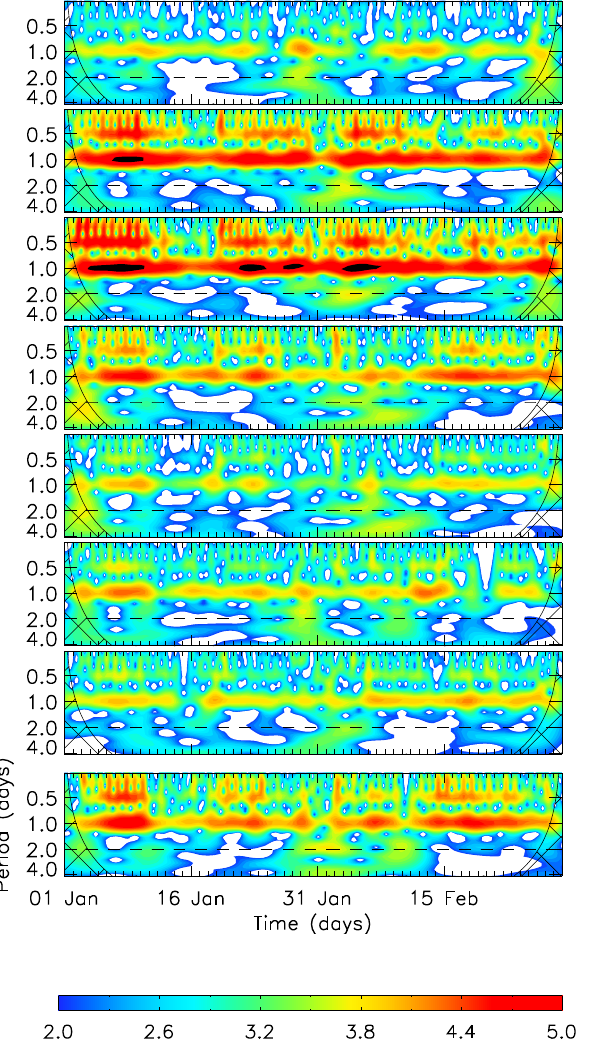
Fig. 3. Space-scale energy density in log-scale of the amplitude of the diurnal tide (0.90–1.15 days) in January-February 2003 for the eight magnetic stations (from top to bottom): ASC, SLZ, HUA, TIR, PND, BNG, GUA, and